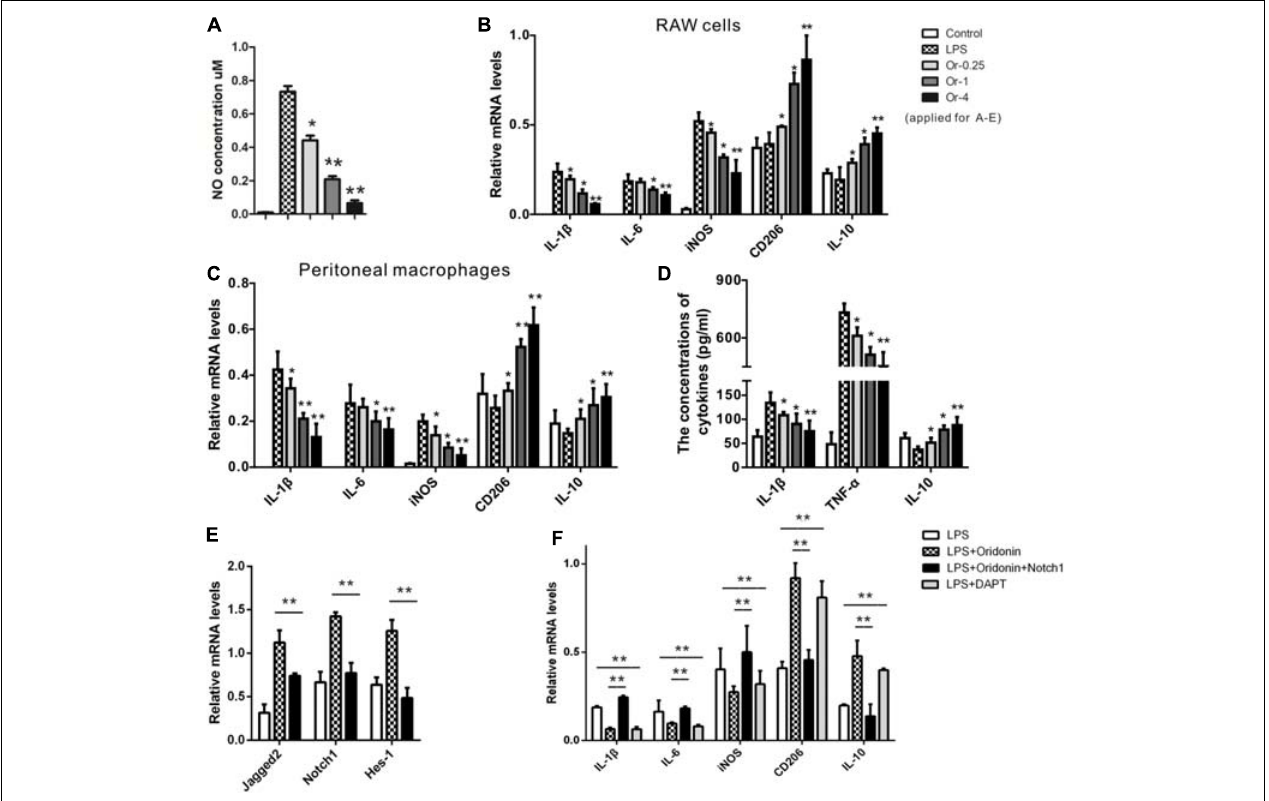
FIGURE 1 | Effects of Oridonin on phenotypic switch of macrophage polarization and Notch pathway in vitro . In vitro cultured macrophage cells were stimulated by LPS, transfected with Notch1 or vehicle plasmid, and treated with Oridonin or DAPT. NO concentrations, proportions of PCR products relative to the house keeping β -actin and cytokine concentrations are presented as bar graphs. (A) Upon the induction of LPS, NO production in RAW cell culture was increased compared to the control. Further, NO concentrations were significantly reduced by Oridonin treatment, in a clear dose-dependent pattern. (B,C) In both RAW cells and primary macrophages, the RNA levels of IL-1 β , IL-6 and iNOS, the markers of inflammatory macrophages, were significantly decreased by Oridonin treatment. On the contrary, CD206 and IL-10 mRNA levels, the markers of anti-inflammatory phenotype, were significantly increased. All these results also presented clear dose-dependent patterns. (D) ELISA assays showed that the concentrations of IL-1 β and TNF- α were reduced by Oridonin treatment and the level of IL-10 was increased in primary macrophages, in a dose-dependent pattern as well. (E) mRNA levels of Notch pathway involved molecules Jagged-2, Notch1 and Hes-1 were remarkably inhibited by Oridonin treatment in RAW cells. (F) In RAW cells, increased mRNA levels of IL-1 β , IL-6 and iNOS were induced by LPS. Their levels were decreased by Oridonin or DAPT, whereas the levels of CD206 and IL-10 were reversed. But the Oridonin’s effects were abolished by the transient transfection of Notch1. Cells from the other groups were all transiently transfected with vehicle plasmid. (Or-0.25, -1, -4 = Oridonin concentrations of 0.25, 1, and 4 µ M. ∗ p < 0.05, ∗∗ p < 0.01 compared to their respective controls). Graphs show mean ± SEM of triplicate wells and represent data from three independent